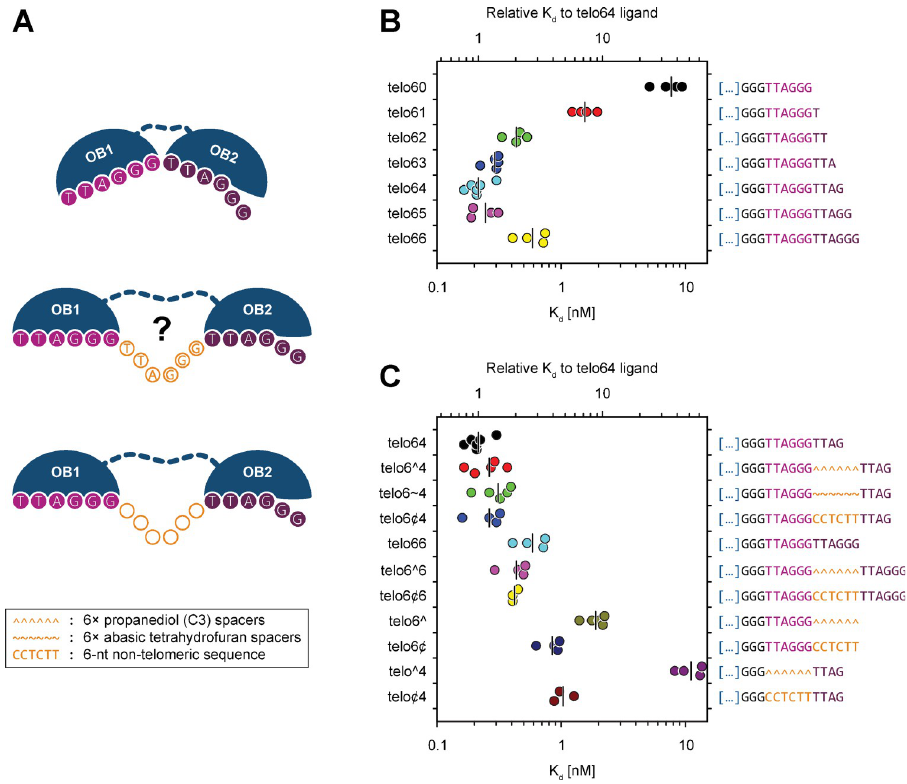
Fig 6. EMSA demonstrate that binding of telomeric ssDNA to the POT1 OB1/OB2 domain is not limited to the minimal binding sequence, but to sequences separated by spacers as well. ( A ) Cartoon representation of the POT1 OB1/2 domains and its possible binding conformations that can allow binding to the minimal tight binding sequence TTAGGGTTAG (top), or the same sequence separated by either a single telomeric repeat (center) or a ~6-nt long non- telomeric spacer (bottom). ( B ) Horizontal scatter plot with median marking of the apparent binding affinity of various telomeric ligands for the POT1-TPP1-TIN2(1–354) subcomplex. Each individual K d value was computed from the EMSA data shown in S6B–S6H Fig. The binding experiments confirm that telo64 is truly the minimal tight-binding sequence. Both shorter and longer oligos, with the notable exception of telo65 ligand, present reduced affinities for the subcomplex. ( C ) Horizontal scatter plot with median marking of the apparent binding affinity of various non- contiguous telomeric ligands for the POT1-TPP1-TIN2(1–354) subcomplex. Each individual K d value was computed from the EMSA data shown in S6I–S6Q Fig. The binding experiments show that the minimal tight-binding sequence ligands that have been interrupted with various non-telomeric spacers retain binding affinity comparable to that of the contiguous telo64